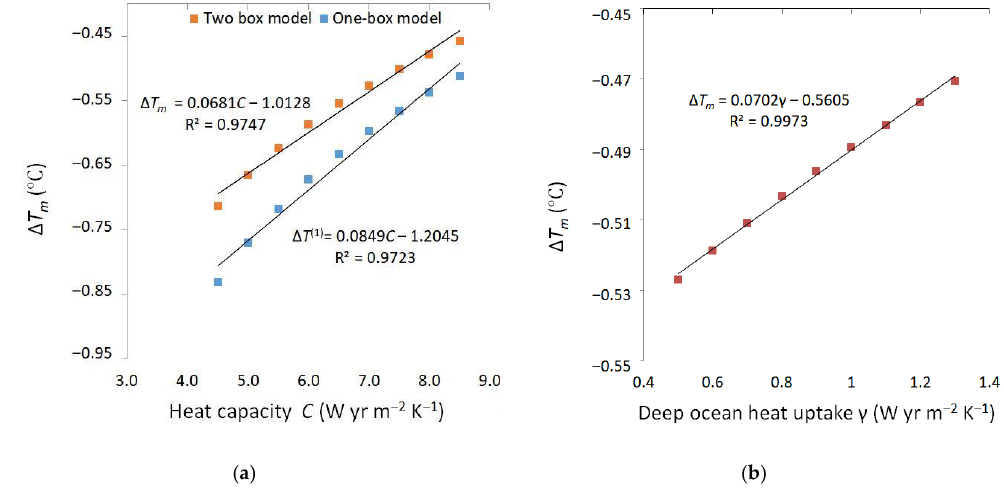
Figure 5. Climate system response Δ𝑇 𝑚 (℃) to volcanic aerosol radiative forcing as a function of ( a ) effective heat capacity 𝐶 (W yr m −2 K −1 ) and ( b ) deep-ocean heat uptake parameter 𝛾 (W m −2 K −1 ) . Table 2. Absolute 𝛿(∆𝑇 𝑚 ) (℃) and relative [𝛿(∆𝑇 𝑚 ) ∆𝑇 𝑚 ⁄ ] (%) uncertainties in model output caused by ±10% uncertainty in model parameters.